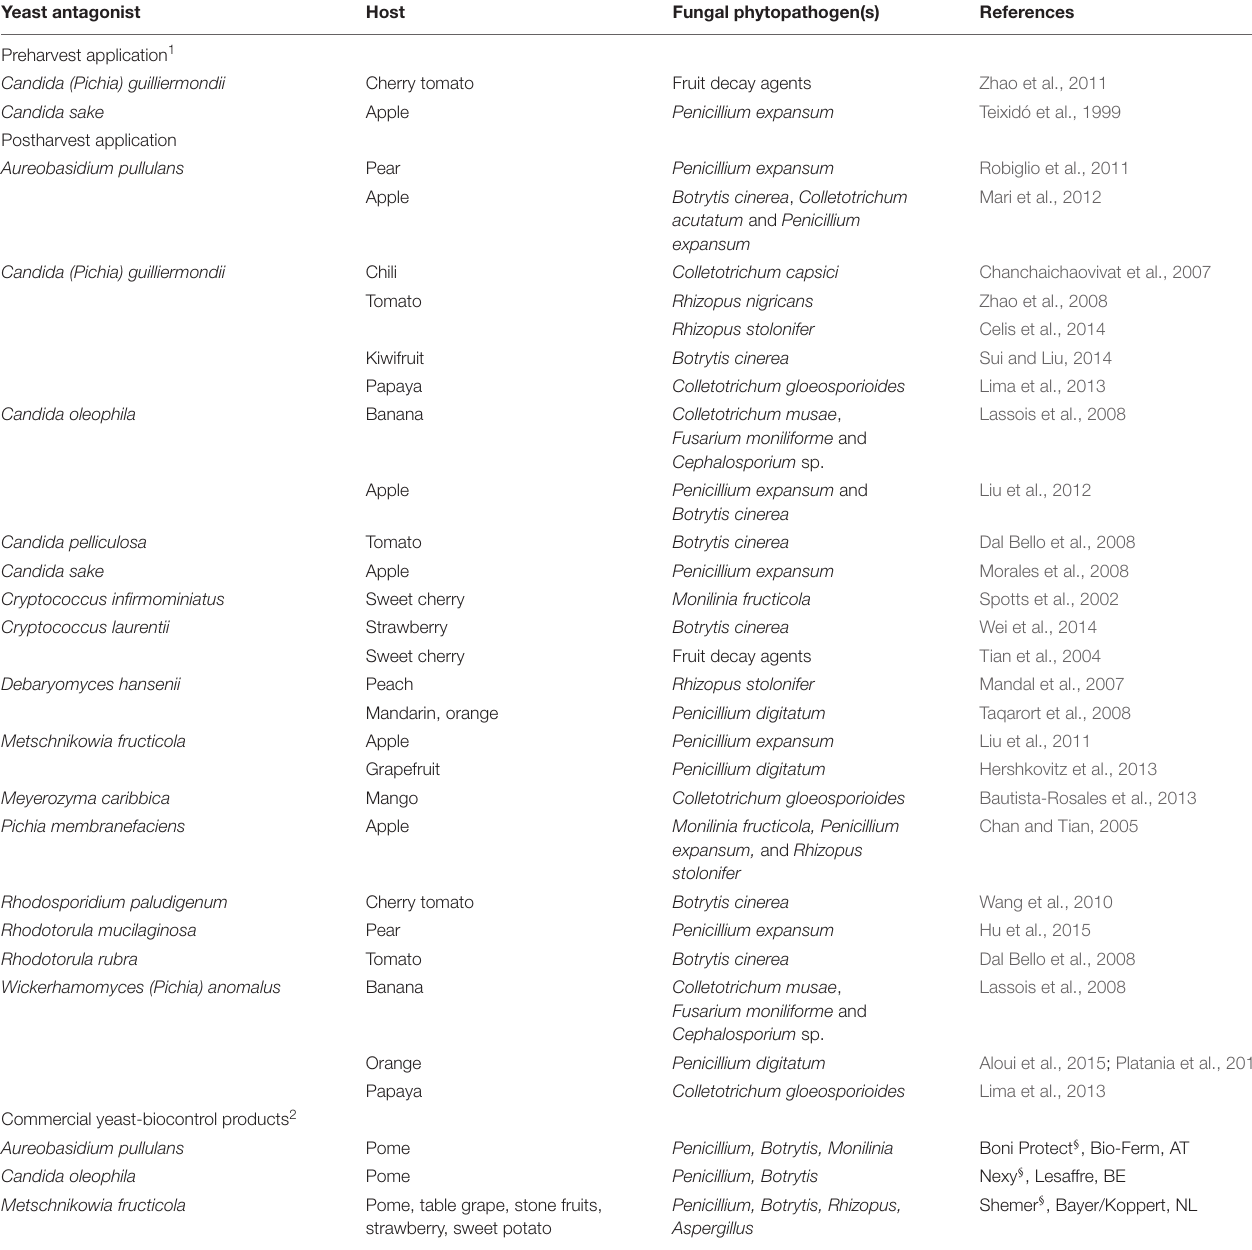
TABLE 1 | Success cases of using yeasts to antagonize the spoilage of fruits by filamentous